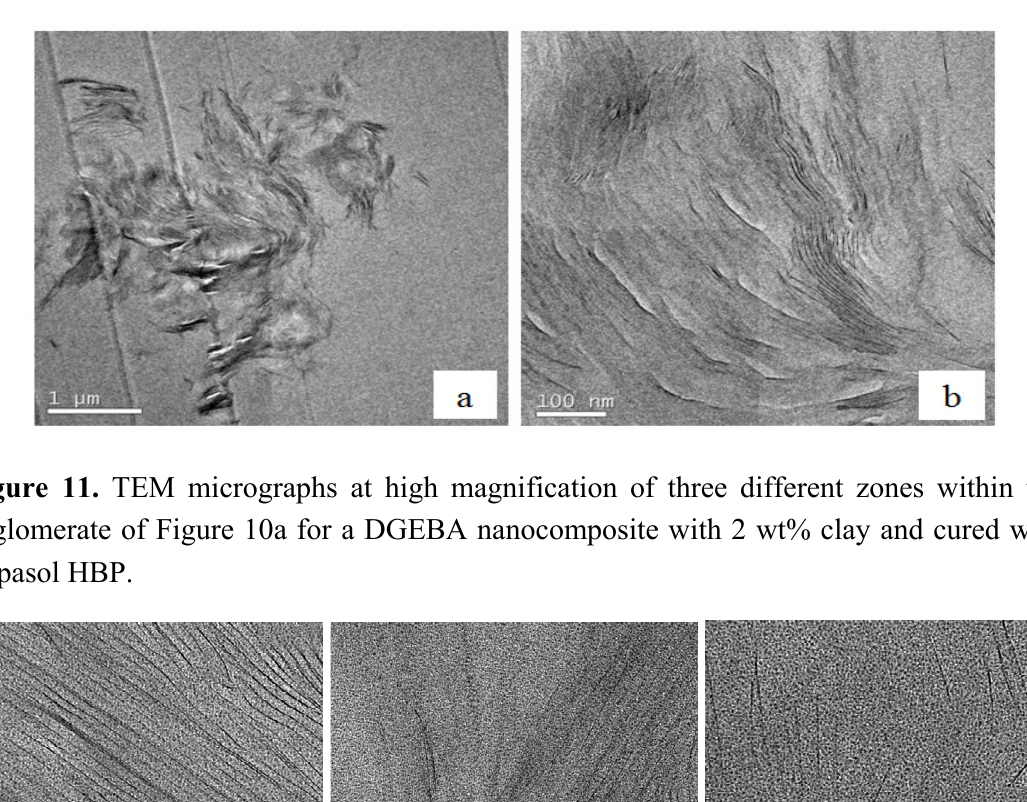
Figure 10. TEM micrographs at low magnification of DGEBA nanocomposite with 2 wt% clay and cured with Lupasol HBP: ( a ) one of the agglomerations in the sample; ( b ) higher magnification of the interior of the agglomeration in ( a ).